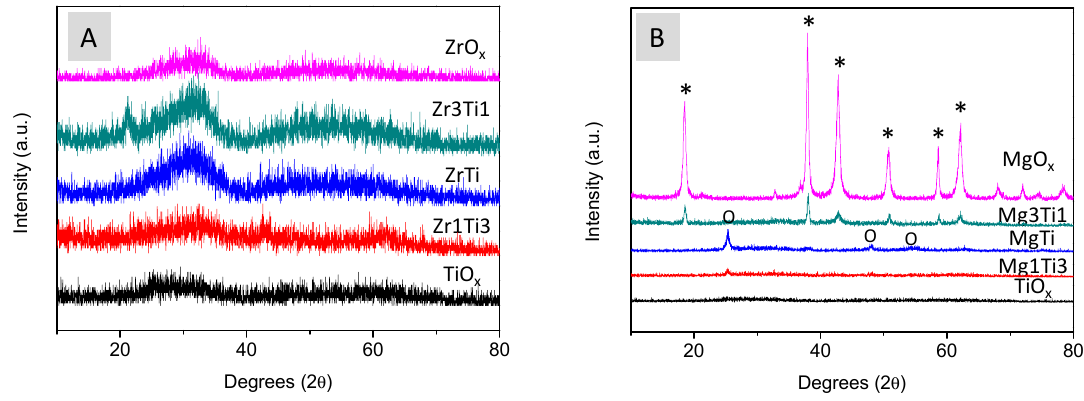
Figure 3. X-ray diffractograms of the different solids synthesized in the present work. Zr-Ti solids ( A ) and Mg-Ti systems ( B ). The corresponding pure compounds have also been included for the sake of comparison. * and ◦ denote brookite and pseudobrookite phases, respectively.